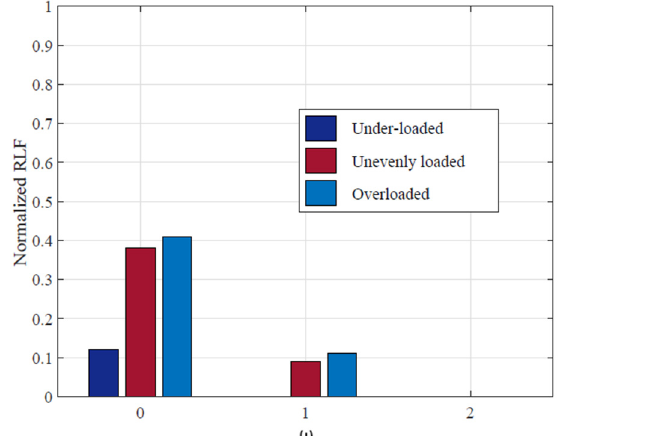
different ω ; ( b ) Bandwidth distribution with the number of iterations.